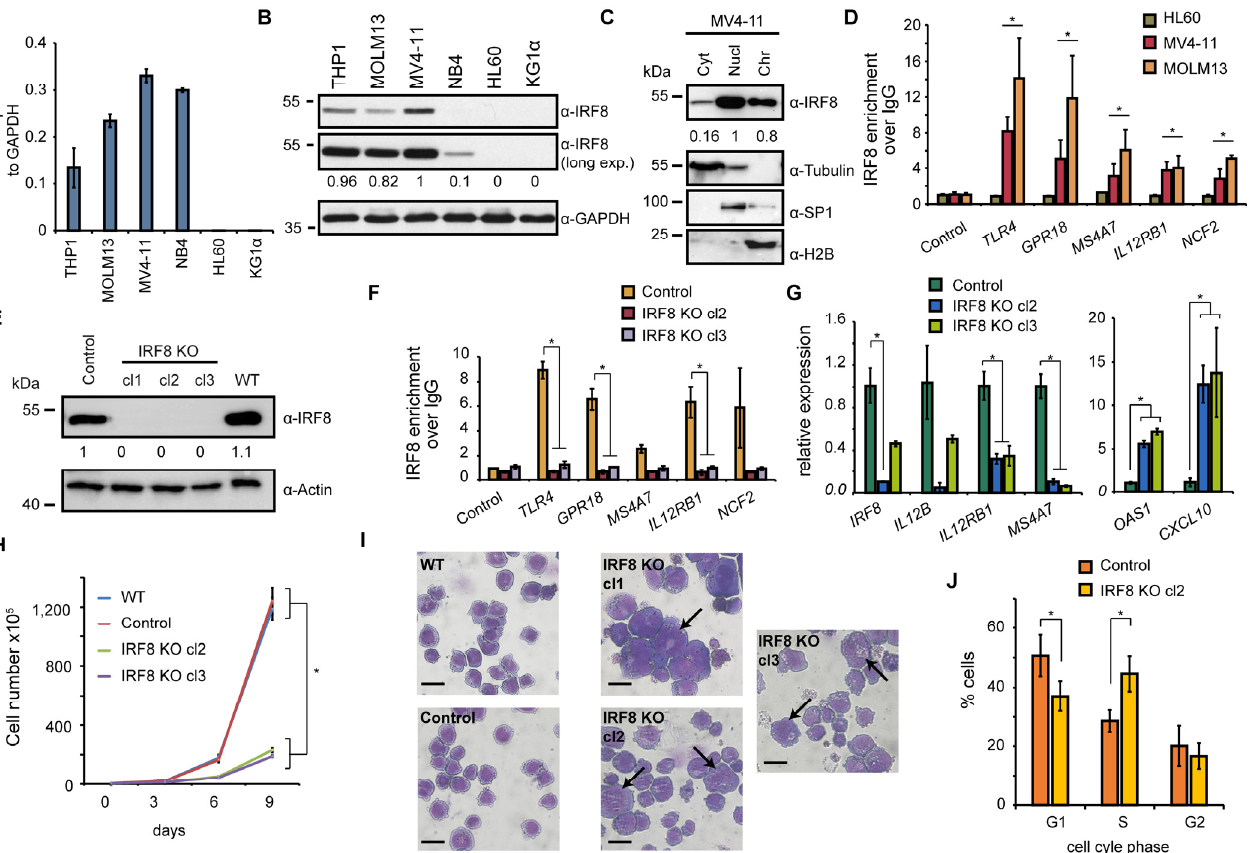
Figure 3. IRF8 deletion impairs cellular function of MV4-11 cells. ( A ) Gene expression of IRF8 relative to GAPDH in several AML cell lines, measured by RT-qPCR ( n = 2). ( B ) Western blot of IRF8 in AML cell lines. ( C ) Cellular distribution of IRF8 in MV4-11 cells. Tubulin, SP1, and H2B were used as controls for cytoplasm (Cyt), nucleoplasm (Nucl), and chromatin-bound fractions (Chr), respectively. ( D ) ChIP-qPCR experiments at several IRF8 target genes in HL60, MV4-11, and MOLM13 cells. Significance was calculated by comparing IRF8 targets versus the control genomic region ( n = 2). ( E ) Western blot of IRF8 knockout clones in MV4-11 cells, compared to wildtype (WT) and cells infected with a non-targeting CRISPR construct (Control). ( F ) ChIP-qPCR at IRF8 target genes using IRF8 antibody in IRF8 KO cells compared to control cells ( n = 2). ( G ) Gene expression changes of interferon response genes upon IRF8 deletion in MV4-11 cells ( n = 2). ( H ) Cell counting of wildtype, CRISPR control and IRF8 knockout cells ( n = 2). ( I ) Pappenheim staining of IRF8 knockout cells in comparison to control cells. Arrows indicate enlarge cells. Scale = 10 µm. ( J ) Cell cycle analysis of IRF8 knockout cell (clone 2) in comparison to control cells ( n = 2). * p < 0.05 (Student’s t -test). The uncropped blots are shown in Figure S1.